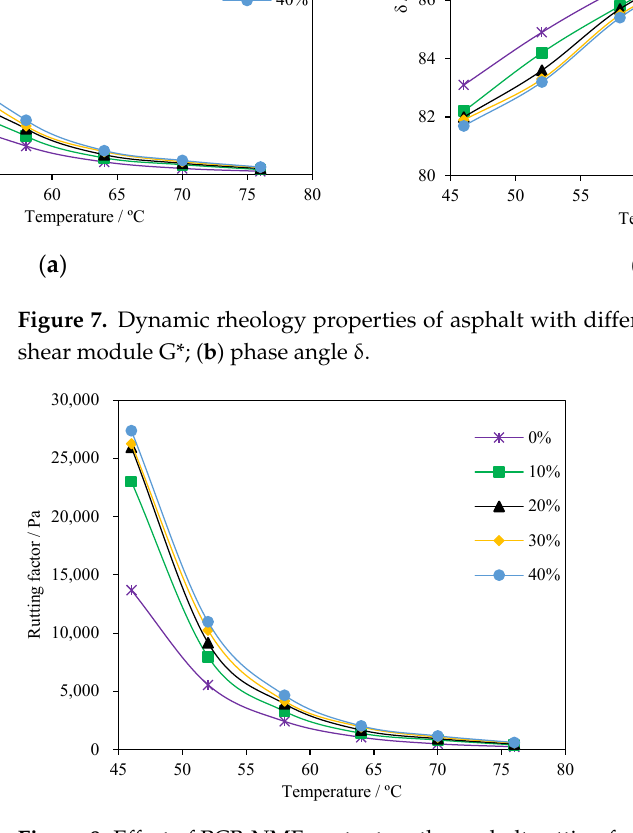
Figure 8. Effect of PCB-NMF content on the asphalt rutting factor G*/sin δ . Table 4. High-temperature grade of PG classification.